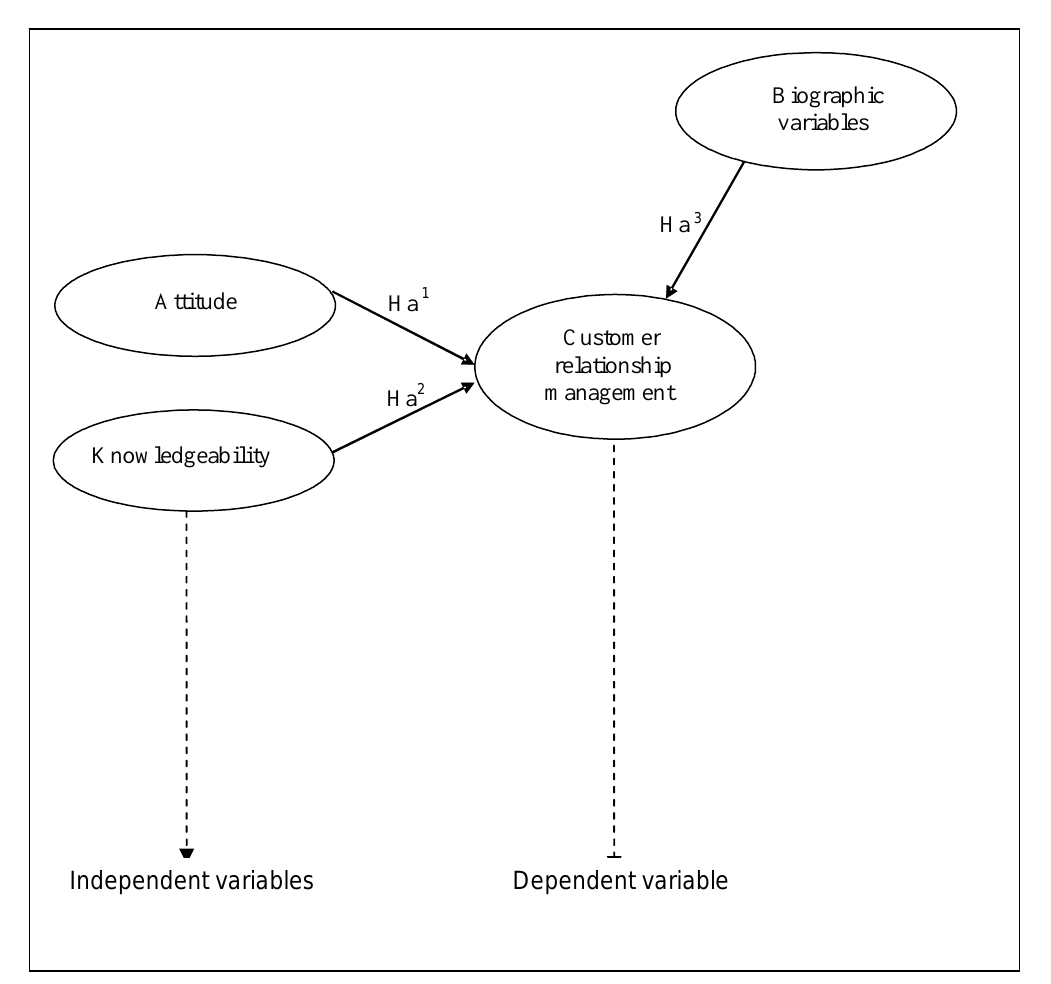
Figure 1: Conceptual